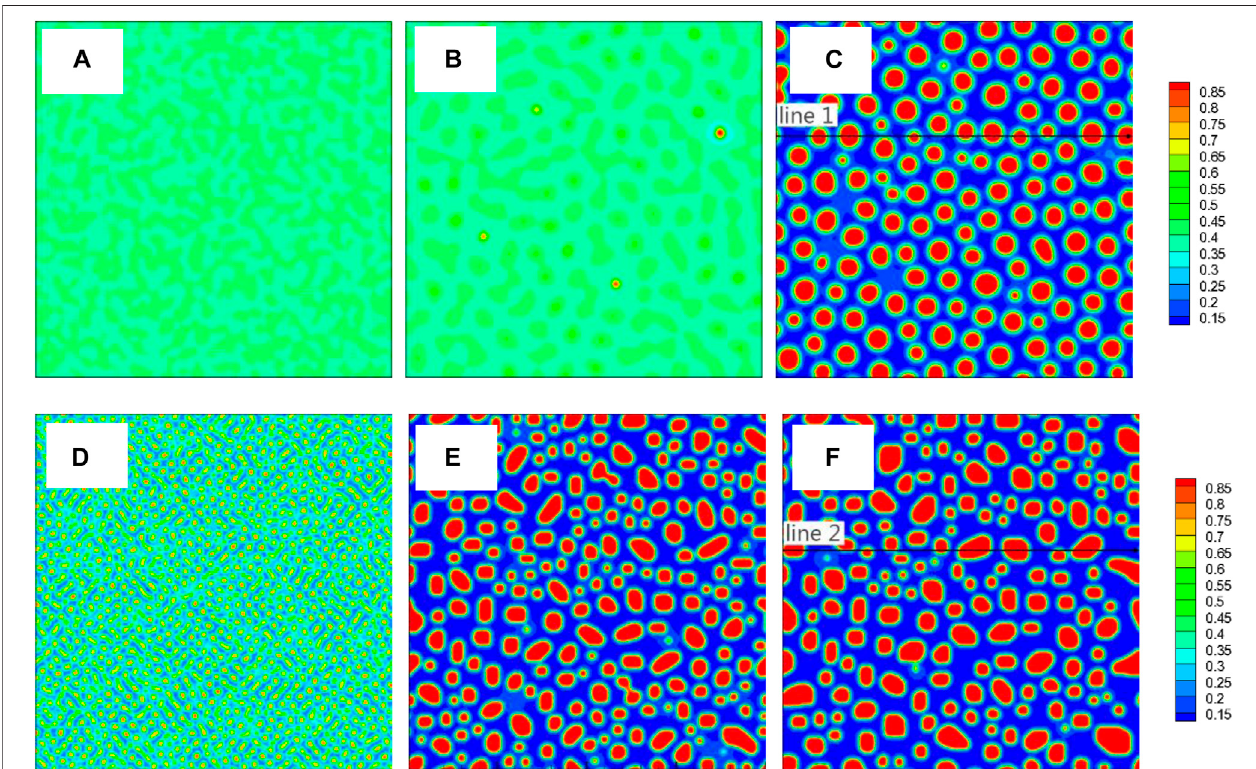
FIGURE3| (coloronline)Images ofconcentration fi eldcorrespondingtothreedifferentmoments fromthetwoTDB fi les,TDB1: (A) 1 × 10 3 Δ t , (B) 5 × 10 4 Δ t , (C) 1 × 10 5 Δ t , TDB2: (D) 1 × 10 3 Δ t , (E) 5 × 10 4 Δ t , (F) 1 × 10 5 Δ t . The concentration along the two black lines in (C) and (F) will be shown in Figure 4